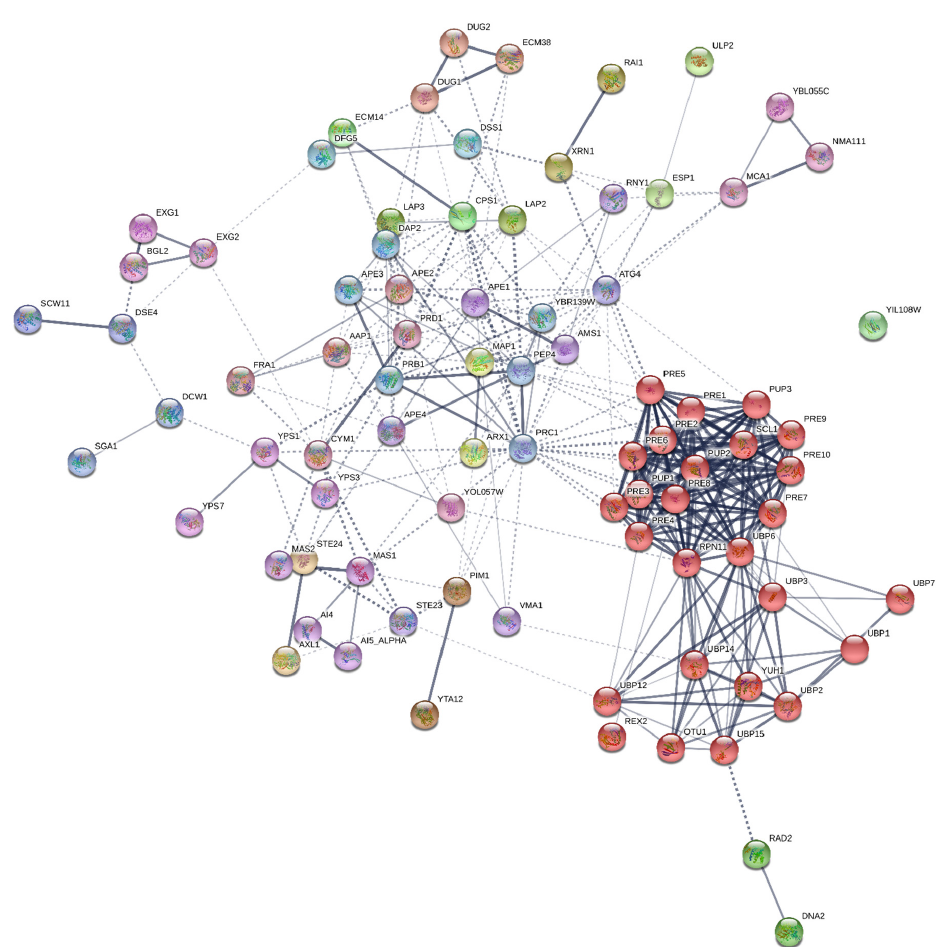
Figure 4. Interaction network map built using STRING v11.0 and based on the 84 autolysis-related proteins in total detected in S. cerevisiae P29 and G1. Proteins are shown as nodes and the existence of interactions between them are represented by edges (connection between nodes). Edges thickness indicates the strength of the different interactions. Nodes with the same color represent specific clusters. PPI enrichment p ‐ value < 1 × 10 − 16 .